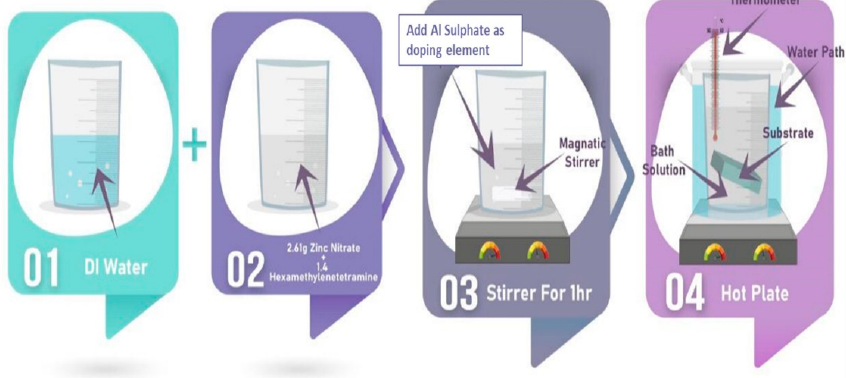
Figure 2. The steps followed for the preparation of AZO via CBD approach.